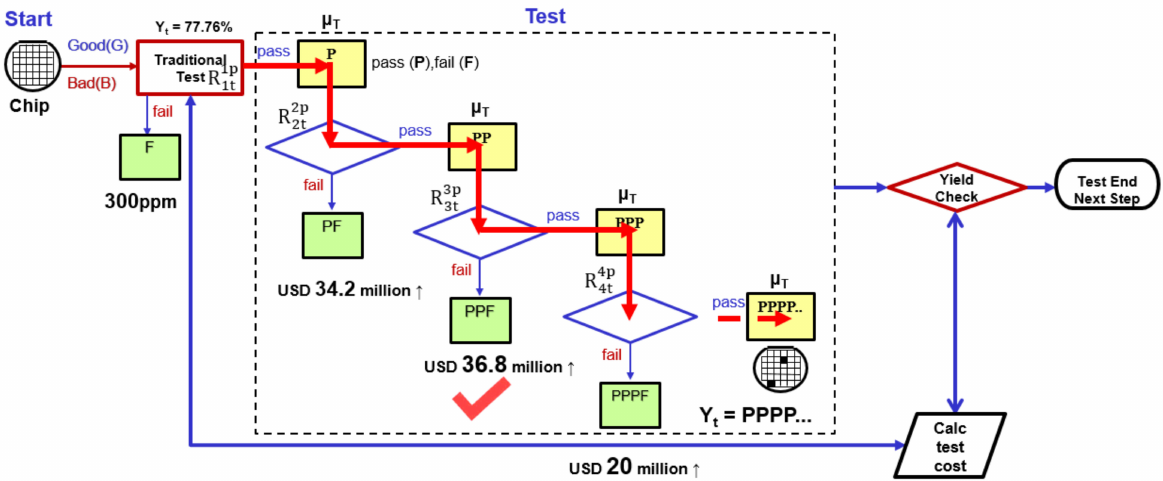
Figure 9. Decision-making mechanisms of the three-repetition tests scheme (300